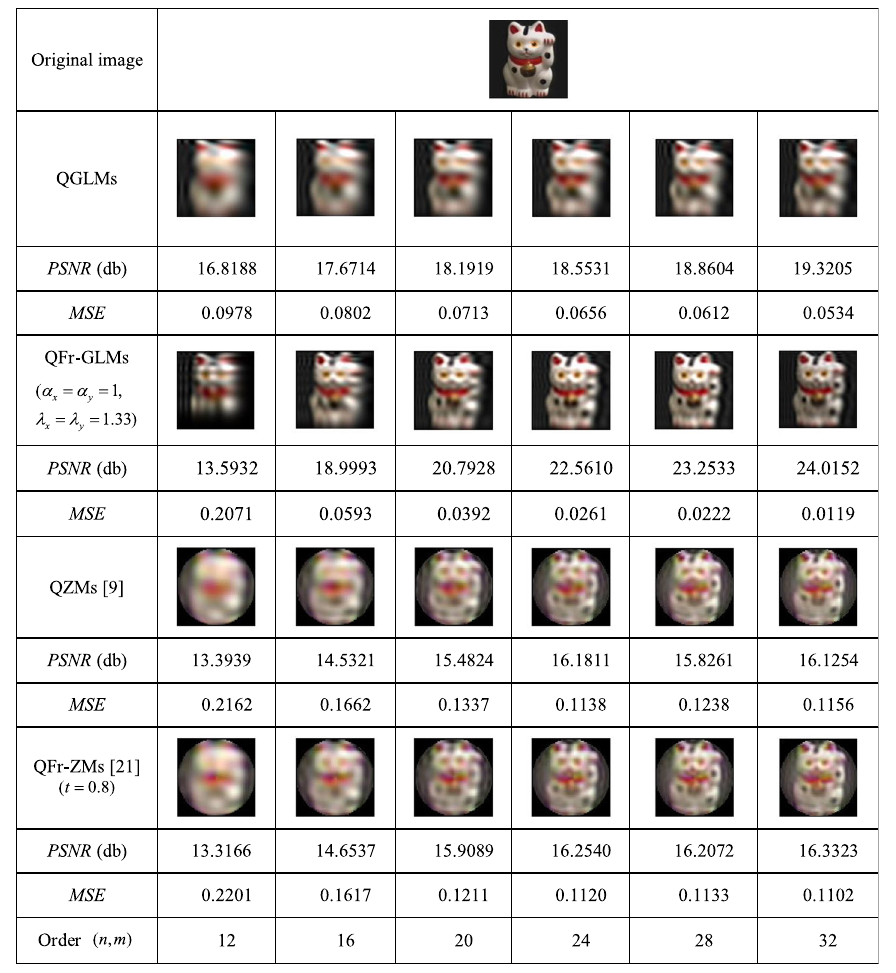
Table 1 Reconstruction performance comparison of different color-image in lower-order